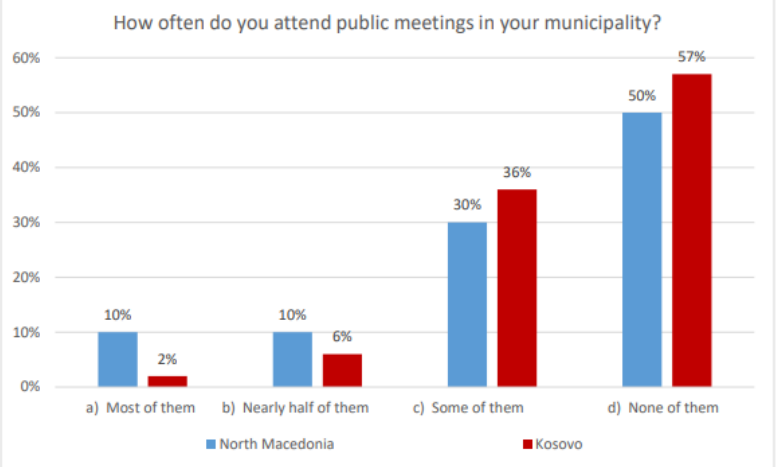
Figure 2: Cooperation between Local Communities - Intercultural Communication (Source: Kamberi and Vejseli 2019-2020)